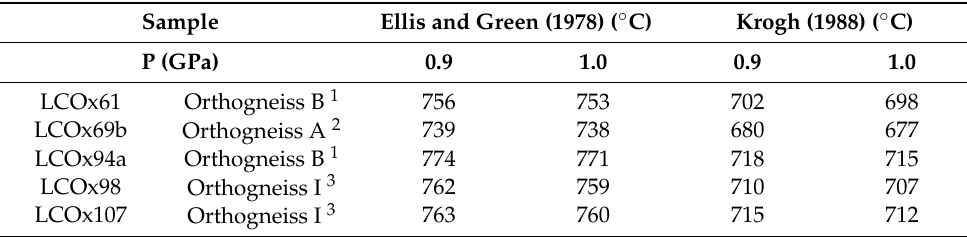
Table 4. Results of Grt-Cpx calibrations from [51,52] were used with two inputs of P: 0.9 GPa and